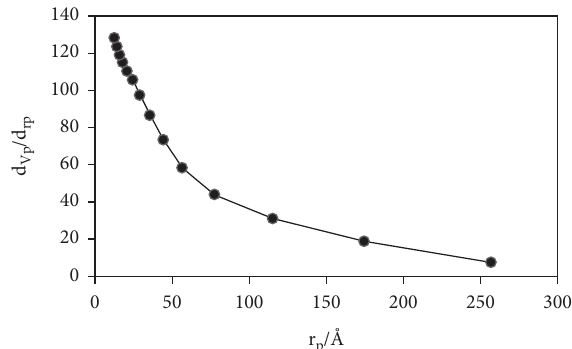
Figure 5: Size distribution of pores measured according to BJH theory for the